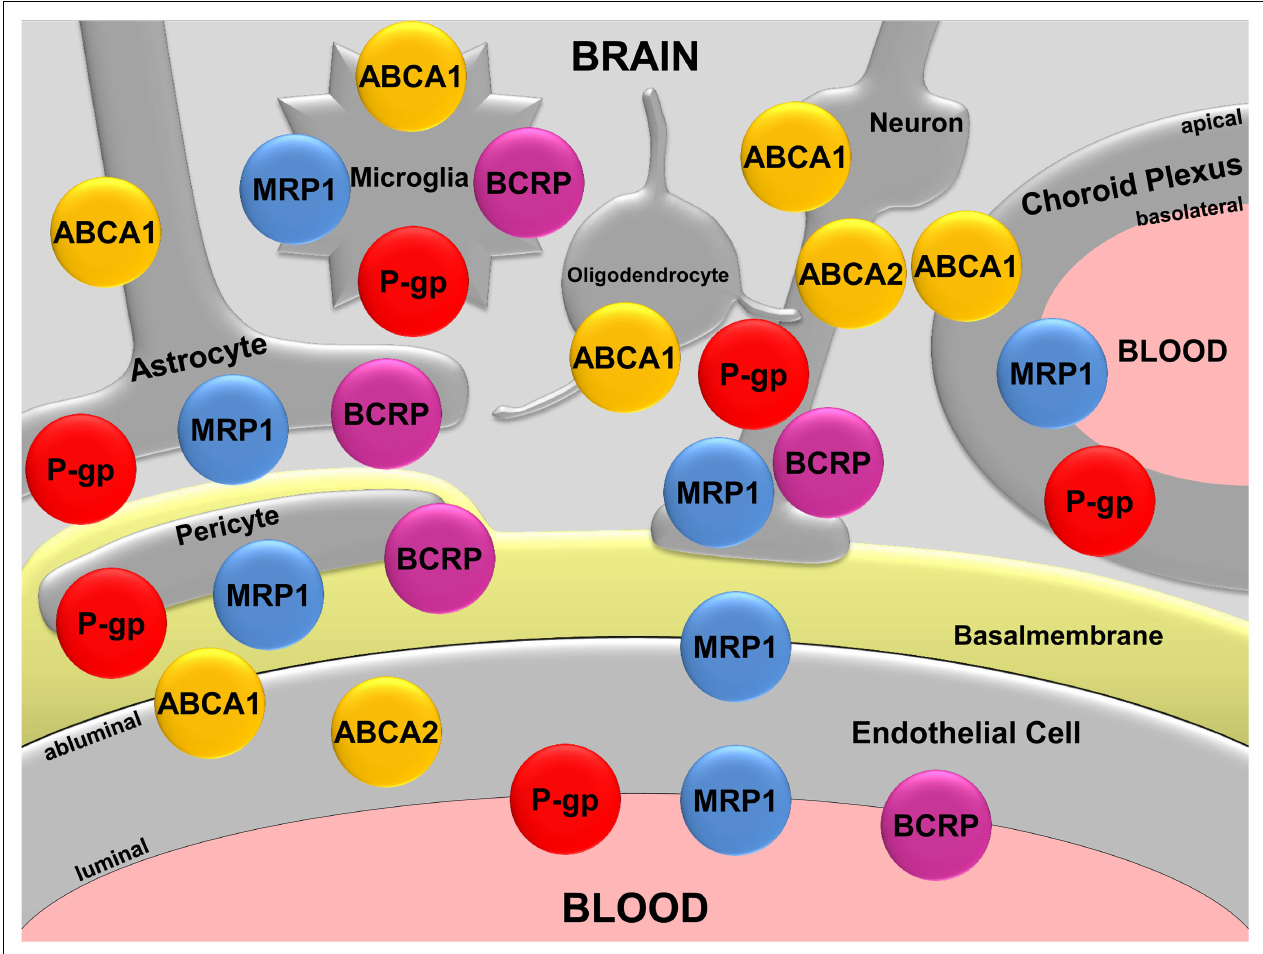
FIGURE 1 | Map of theABC transportersABCA1,ABCA2, P-gp, MRP1, and BCRP in the CNS. Modified according to Hartz and Bauer